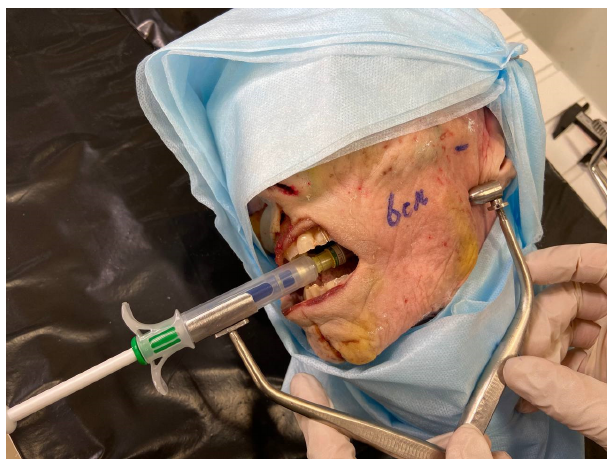
Figure 5. Usage of developing navigation system for IANB, performed by disposable syringe «Arti- ject».